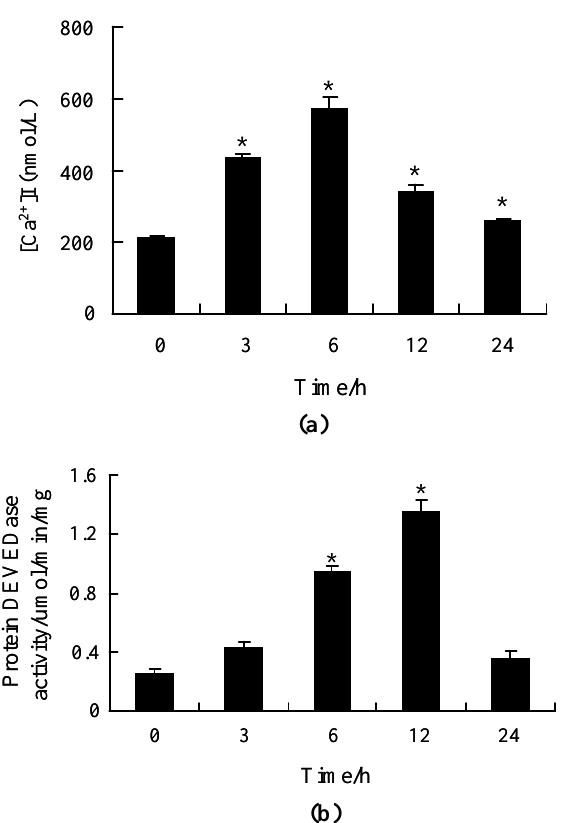
Figure 3. The variation of intracellular [Ca 2+ ]i and activity of Capase-3 treated with TGF-  1 . (a) The concentration changes of intracellular Ca 2+ within mammary epithelial cells treated with TGF-  1 . (b) The activity changes of Capase-3 within mammary epithelial cells treated with TGF-  1 at different durations (0, 3, 6, 12, 24 h). * Indicates a significant difference between treated groups and control (p<0.01).